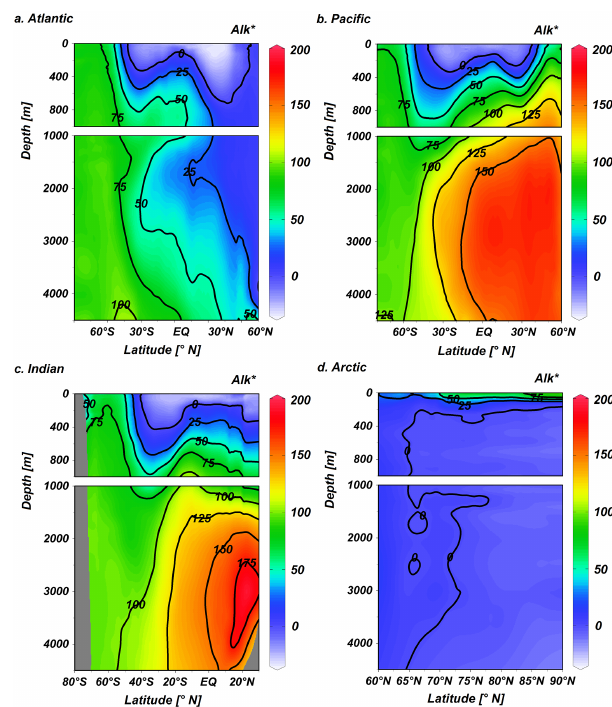
Figure 3. Zonal mean gridded Alk ∗ (in µmolkg − 1 ) in the (a) At- lantic, (b) Pacific, (c) Indian, and (d) the Arctic oceans plotted against latitude and